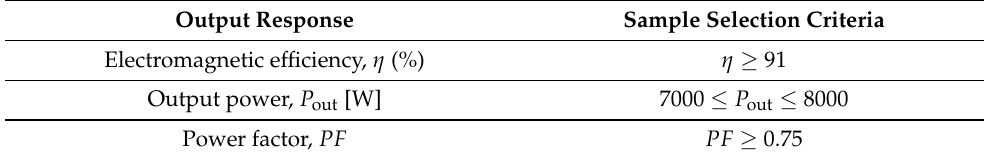
Table 5. Sample selection criteria from the Latin-hypercube sampling method.